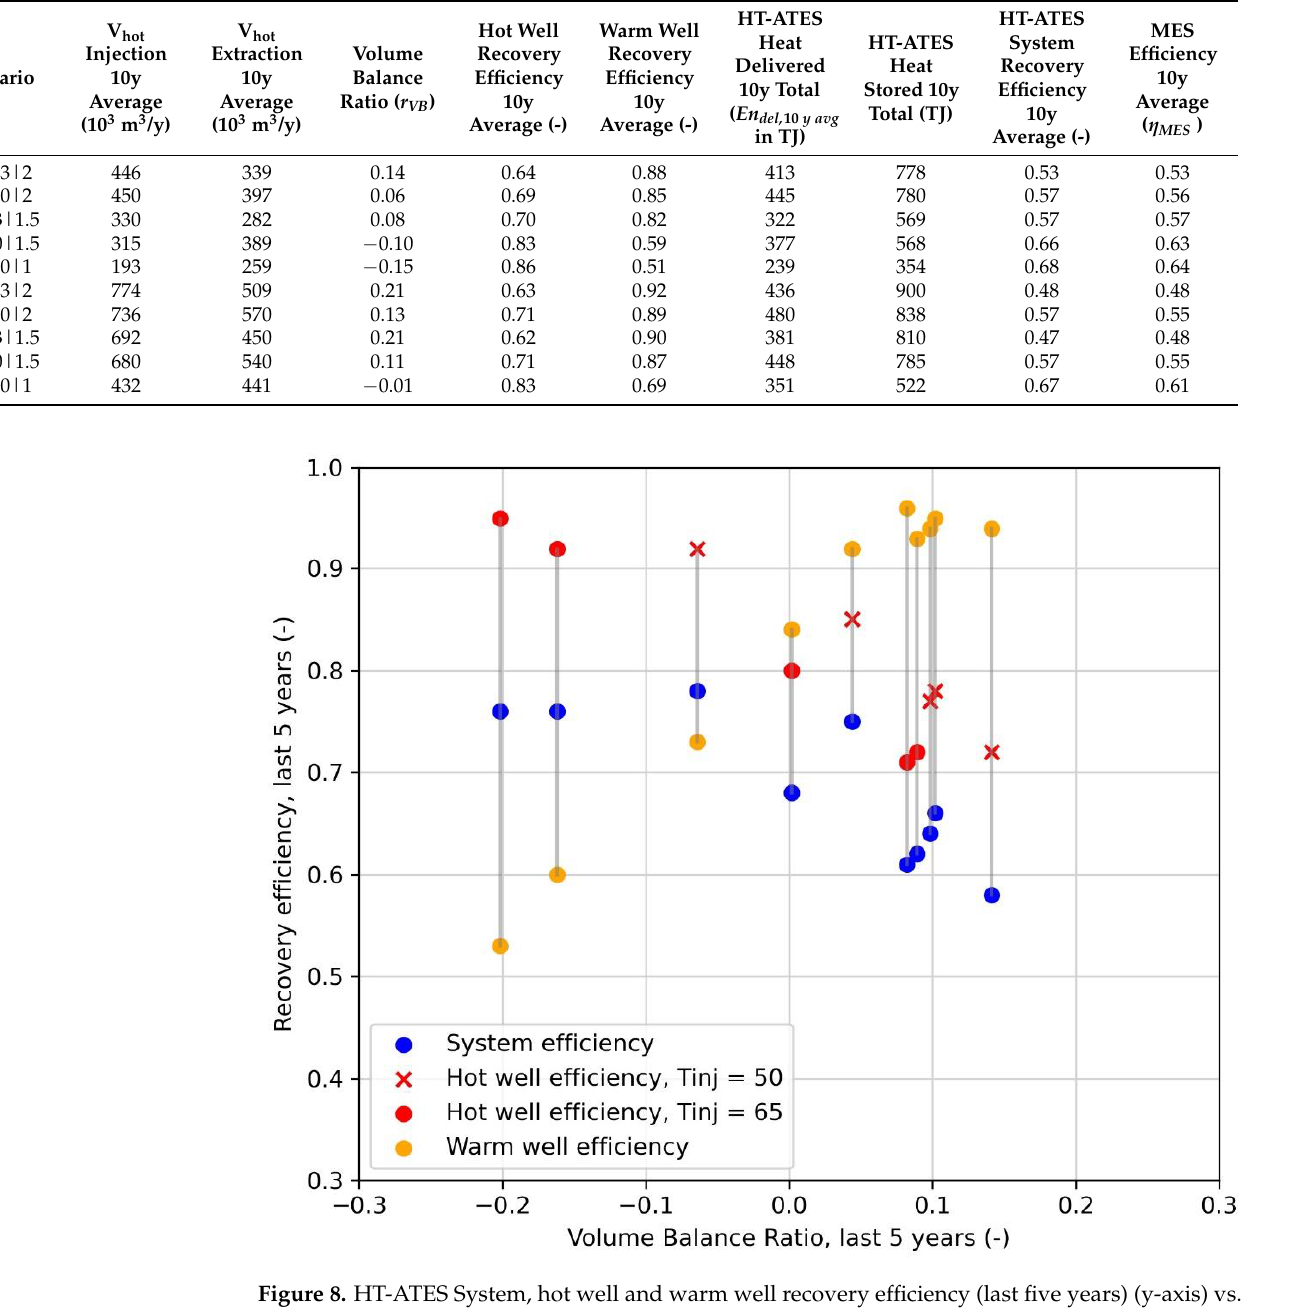
Table 5. Ten-year average HT-ATES performance results. The amount of stored energy is mainly determined by the size of the heat pump and the temperature levels. This subsequently results in different amounts of stored volumes and recovery efficiencies. The scenario name abbreviation consists of: condenser temperature|HT-ATES threshold temperature|heat pump size .